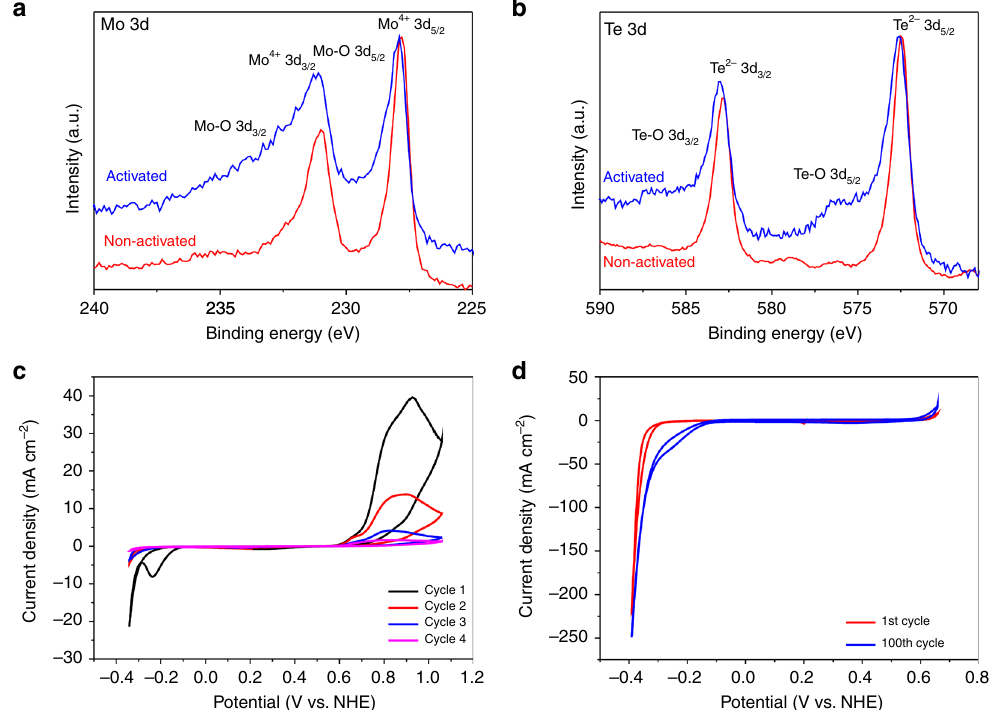
Fig. 5 Investigation into the activation mechanism of nanocrystalline 1T ′ -MoTe 2 . a 3d Mo XPS spectra of activated (after 100 cycles) and non-activated nanocrystalline 1T ′ -MoTe 2. b 3d Te XPS spectra of activated and non-activated nanocrystalline 1T ′ -MoTe 2 . c Cyclic voltammograms showing the consequent deactivation of nanocrystalline 1T ′ -MoTe 2 in 1 M H 2 SO 4 under a nitrogen atmosphere using a scan rate of 10 mV s − 1 . During the fi rst anodic sweep, two oxidations occur followed by a decrease in current density at cathodic potentials indicating catalyst deactivation. d Cyclic voltammogram of nanocrystalline 1T ′ -MoTe 2 before and after 100 cycles during which the edge sites are reversibly oxidized/reduced. Measurements were performed in 1 M H 2 SO 4 under a nitrogen atmosphere with a scan rate of 100 mV s −